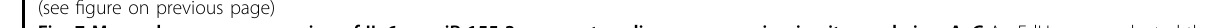
Fig. 7 Macrophage overexpression of IL-6 or miR-155-3p promotes glioma progression in vitro and vivo. A , C An EdU assay evaluated the proliferation of U87MG or U251 cells cocultured with macrophages transfected with control, IL-6, miR-control, or miR-155-3p. S3I-201 was used to inhibit STAT3 activation. The results were quanti fi ed (scale bar, 100 μ m). B , D The migration capacity of U87MG or U251 cells cocultured with conditioned macrophages was determined. Representative images of migratory cells and quanti fi cations are shown (scale bar, 200 μ m). E In vivo bioluminescent imaging analysis of tumor growth in xenograft nude mice bearing U87MG cells with control-macrophages, IL-6-macrophages, miR- control-macrophages or miR-155-3p-macrophages. Representative images on day 5 and 15 post-implantation are shown (data are from fi ve mice per group). F HE staining and IHC staining for Ki-67 of sections from xenograft mouse brains with U87MG and control-macrophages, U87MG and IL-6- macrophages, U87MG and miR-control-macrophages or U87MG and miR-155-3p-macrophages on the day of euthanasia (scale bar, 200 μ m). G Survival analysis of animals implanted with U87MG and control-macrophages, U87MG and IL-6-macrophages, U87MG and miR-control- macrophages or U87MG and miR-155-3p-macrophages ( P < 0.05 by log-rank analysis; data from fi ve animals per group). (* P < 0.05; ** P < 0.01; *** P <